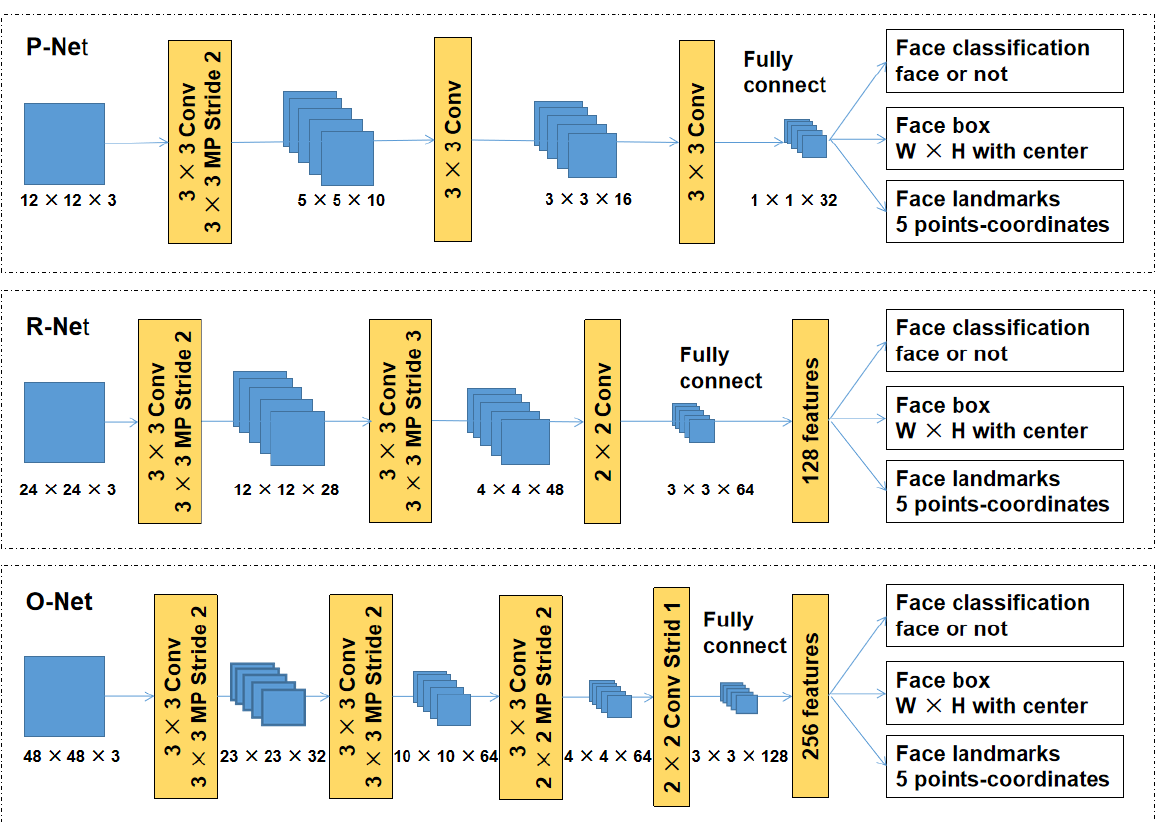
Figure 3. P-Net, R-Net, and O-Net in MTCNN.